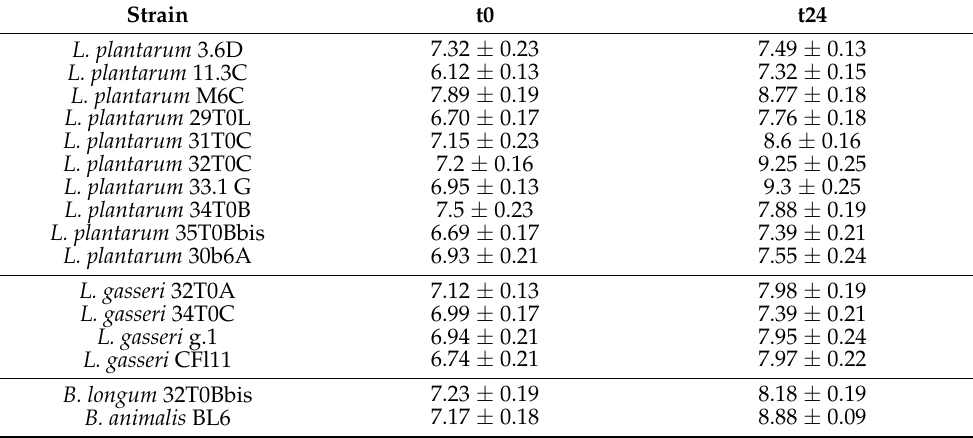
Table 7. Microbial viability of the lactobacilli and bifidobacteria under study in pasteurized whole milk (log CFU/mL) after inoculation (t0) and after 24 h (t24) of incubation at 37 ◦ C. The cell counts are expressed as the average of three replicates; the values are reported ± standard deviations